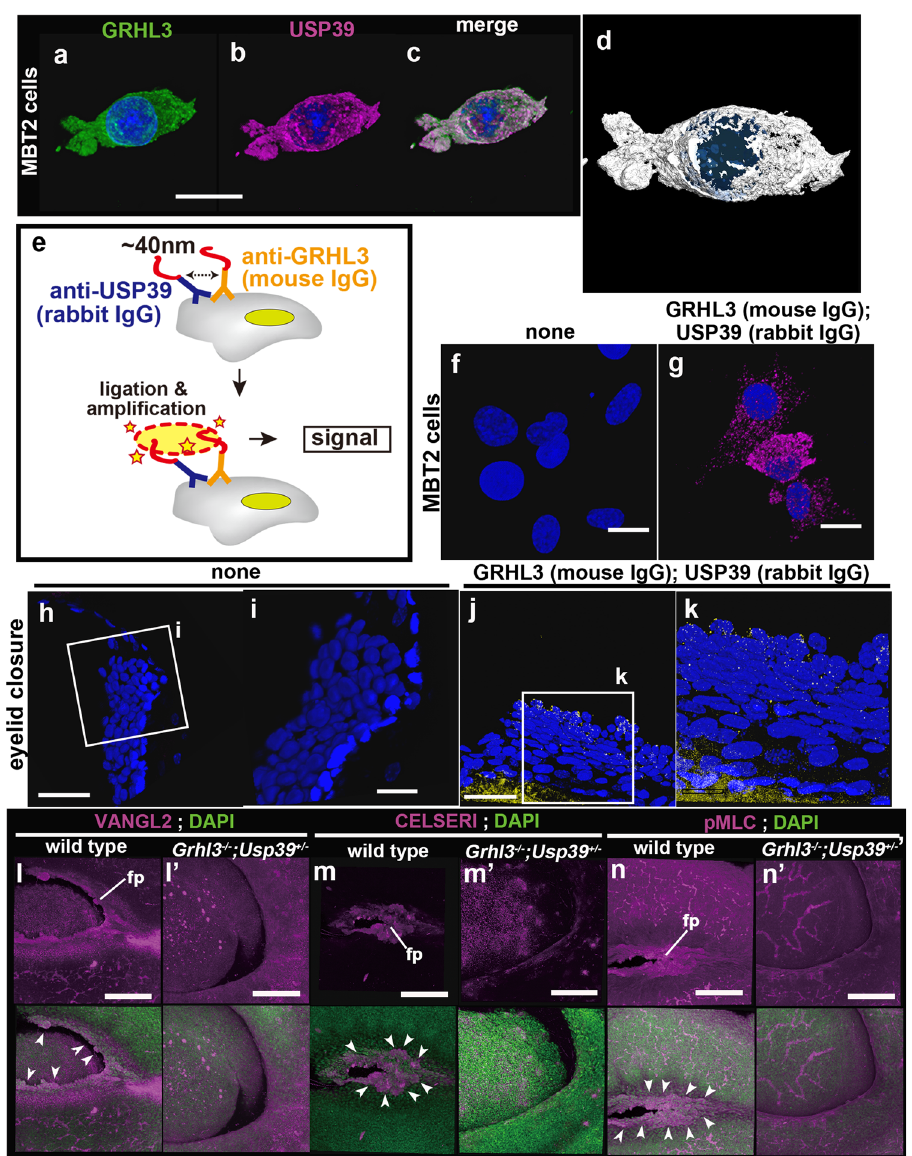
Fig. 8 Detection of USP39-GRHL3 interactions in situ using a Duolink proximity ligation assay (PLA) at endogenous protein levels and expression of planar cell polarity (PCP)-related molecules in Grhl3 − / − ; Usp39 + / − mutant eyelids. a – d Co-localization between GRHL3 (green) and USP39 (magenta) in MBT2 cells by immunohistochemistry and analyzed with Amira software ( d ). e Schematic representation of PLA technology. f – k The speci fi c interactions between USP39 and GRHL3 proteins can be detected as PLA signals ( g , j , k ) in MBT2 cells ( f , g magenta) and eyelid tissues ( h – k yellow). Technical negative controls are conducted in the absence of the fi rst antibodies (none) ( f , h , i ). l – n ′ Planar cell polarity – related molecules are greatly reduced in Grhl3 − / − ; Usp39 + / − mutant eyelids. Arrowheads indicate the corresponding expression in the wild-type fl attened periderm cells (magenta). Expression of VANGL2 ( l , l ′ ), CELSERI ( m , m ′ ), and phosphorylated myosin light chain (pMLC) ( n , n ′ ) in wild-type ( l – n ) and Grhl3 − / − ; Usp39 + / − ( l ′ – n ′ ) embryos. fp fl attened peridermal cells. Scale bars represent 20 μ m ( a – d , f , g , i , k ), 50 μ m ( h , j ) and 200 μ m ( l – n ′ start site of the Grhl3 locus (Fig. S13a) 9 . Grhl3 NLS/NLS defects are protruding neural tissues considered the sacral spina bi fi da due to failure of cytoplasmic GRHL3-dependent epithelial phenotype (Fig. S13f – h). We generated Grhl3 NLS/NLS ; Usp39 + / − compound mutants and measured the degree of protruding neural morphogenesis involving the non-canonical Wnt pathway, but tube. The penetrance of sacral spina bi fi da was almost similar not nuclear GRHL3-dependent transcription involving the cano- between Grhl3 NLS/NLS and Grhl3 NLS/NLS ; Usp39 + / − embryos nical Wnt pathway 9 . NLS-fused GRHL3 was mainly localized in the nucleus of surface ectoderm cells in Grhl3 NLS/NLS embryos ( n = 7/11 and n = 16/24, respectively; p = 0.860 > 0.05). However, as compared with normal full-length GRHL3 in the wild type at Grhl3 NLS/NLS ; Usp39 + / − embryos appeared to display a much E8.5 (Fig. S13b – e). Grhl3 NLS/NLS mutant embryos display neural more severe spina bi fi da phenotype than Grhl3 NLS/NLS embryos tube closure defects and their severity is milder than that of the (Fig. S13g, h). These fi ndings together further support the concept Grhl3 -de fi cient embryos 9 . To evaluate the severity of defects in the that USP39 contributes to GRHL3-dependent developmental double mutant more quantitatively, we measured the degree of processes through the PCP but not canonical Wnt pathway.